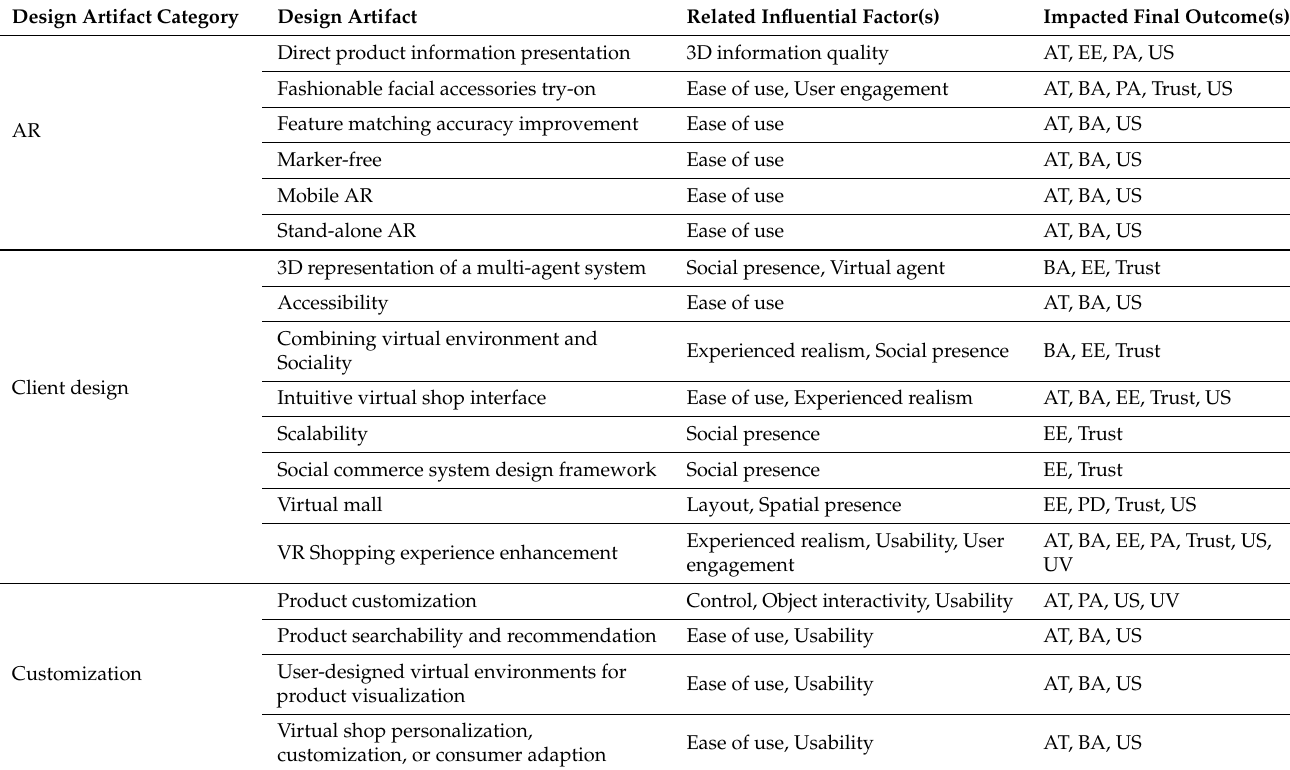
Table 9. Mapping of design artifacts and boundary